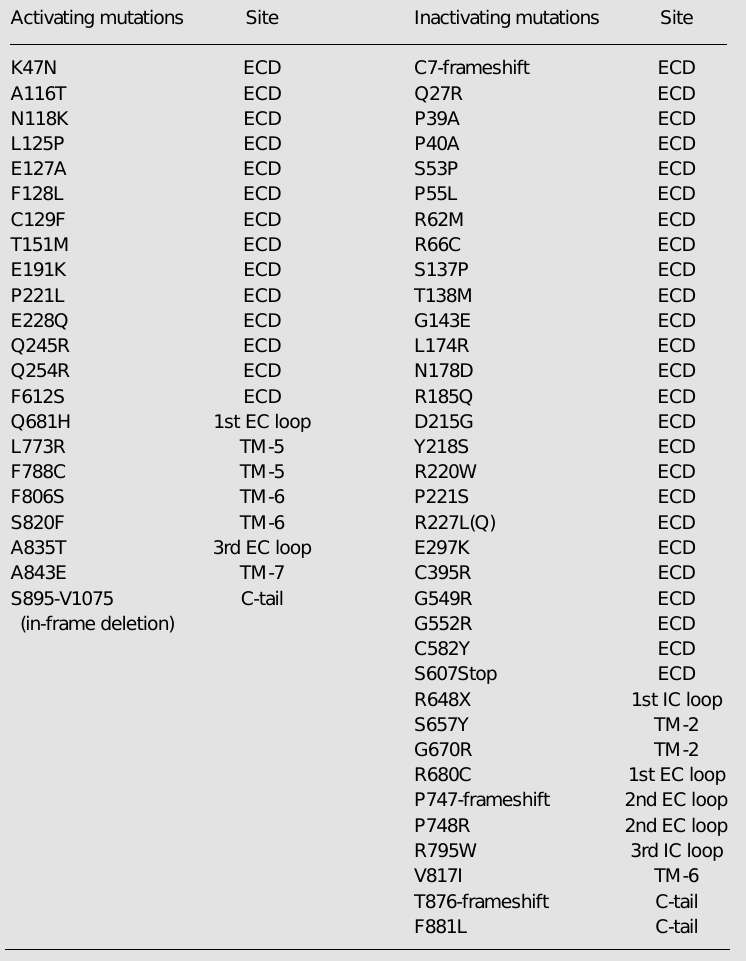
Table 1. Natural activating and inactivating mutations of the human calcium-sensing receptor described to date. Activating